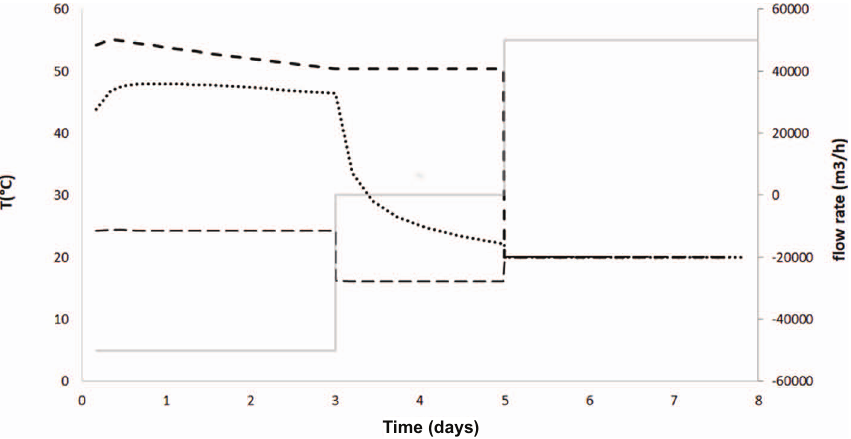
Fig. 7. Wellhead temperatures during an operating sequence of injection and withdrawal – fl ow rate: grey line – temperature for coupled case: dotted – temperature for adiabatic case: dashed line – temperature for in fi nite rock mass conductivity: long dashed line.